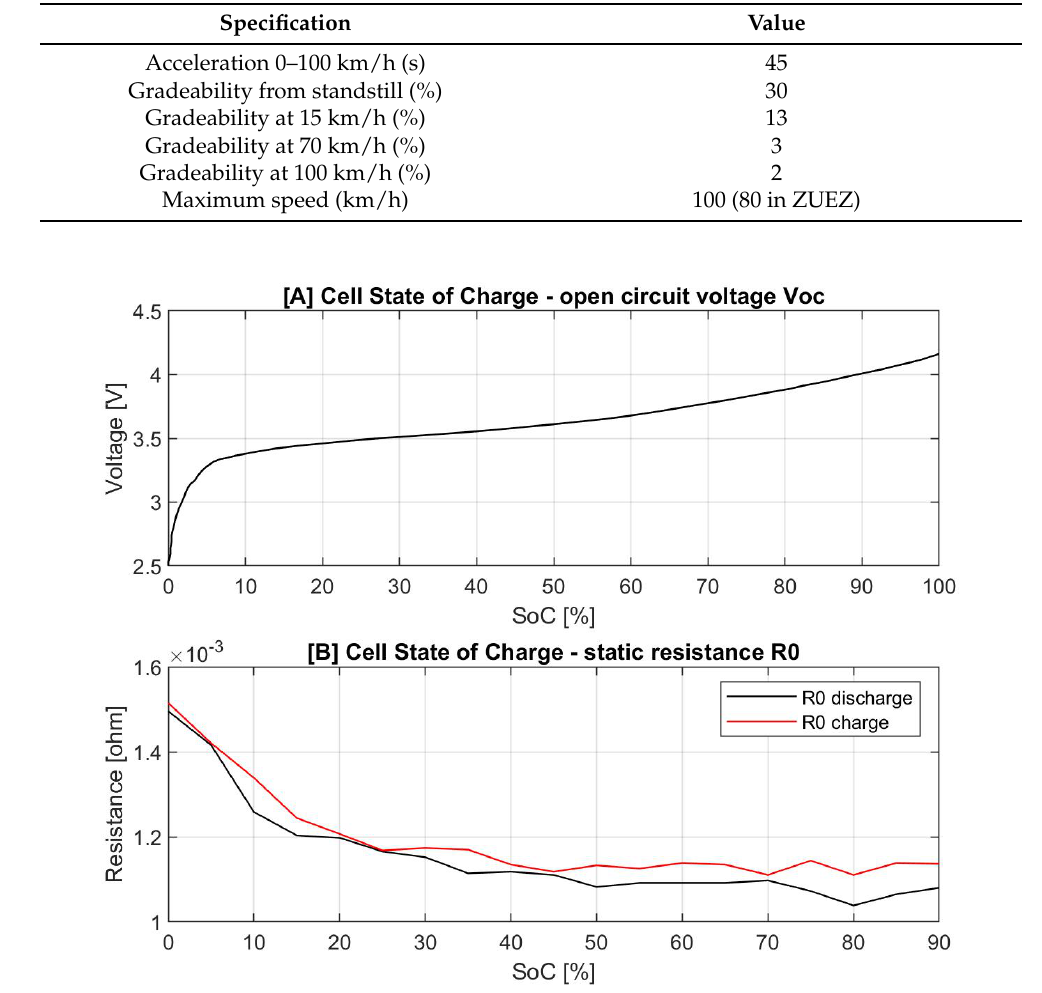
Table 1. Vehicle key performance requirements used for defining powertrain sizing constraints.